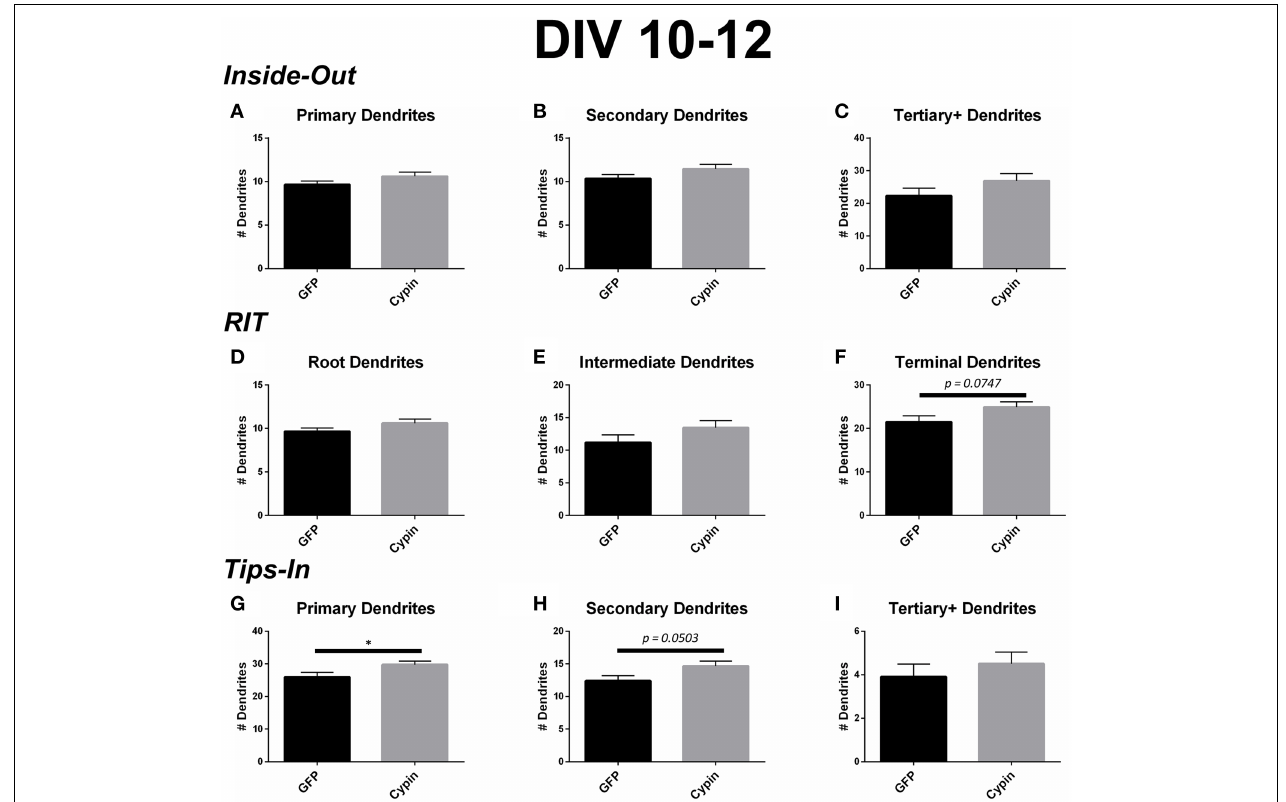
FIGURE 8 | Cypin increases outermost dendrites when overexpressed in neurons from DIV 10–12. ( A–C) Dendrite numbers divided into categories using Inside-Out (conventional) labeling method. (A) Cypin overexpression does not increase the number of primary dendrites. (B) Cypin overexpression does not increase the number of secondary dendrites. (C) Cypin overexpression does not increase the number of tertiary and higher order dendrites. For (A,B) , statistics were calculated by unpaired, two-tailed Student’s t -tests with Welch’s correction, and for (C) , statistics were calculated by unpaired, two-tailed Student’s t -tests. (D–F) Dendrite numbers divided into categories using RIT labeling method. (D) Cypin overexpression does not increase the number of root dendrites. (E) Cypin does not increase the number of intermediate dendrites. (F) Cypin